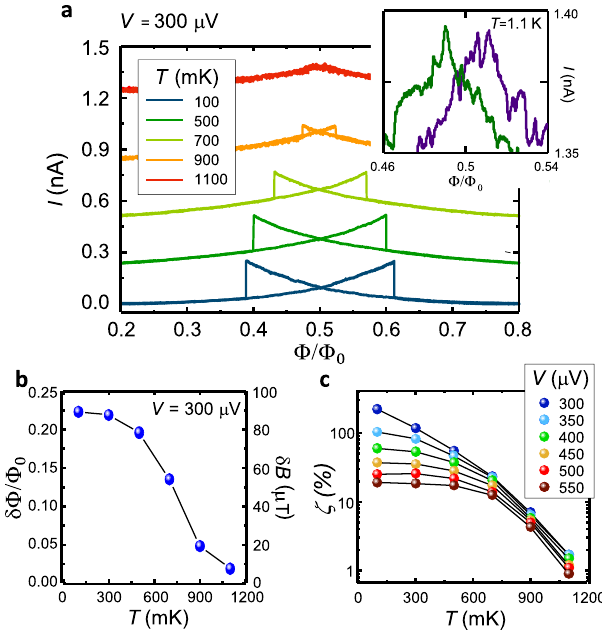
Fig. 5 Temperature dependence of the phase-slip memory. a Current modulation I ( Φ ) for several bath temperatures ( T ) at V = 300 μ V. The hysteresis loop narrows and fades out by increasing the temperature since the superconducting nanowire approaches the short-junction limit at high T . Inset: blow-up of the I ( Φ ) characteristics around Φ 0 /2 at 1.1 K. Forward (purple) and backward (green) traces highlight the presence of hysteresis. b Temperature dependence of δ Φ measured at V = 300 μ V. δ Φ monotonically decreases with temperature. c ζ vs T for selected values of V . ζ drops with temperature, and by increasing V . Black lines in panels b and c are guides for the